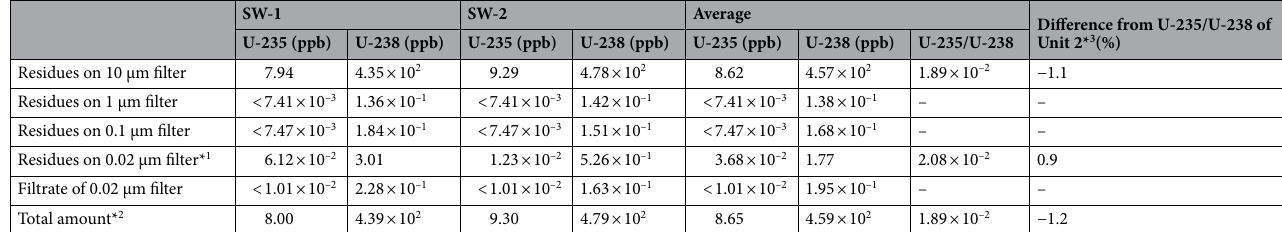
Table 1. U concentrations in the fractions of the stagnant water (SW) sample. *1 Difference in U concentration between a 0.1 and 0.02-µm filter filtrate.*2 Sum of the U concentrations of the 10-, 1-, and 0.1-µm filter residues and the 0.1-µm filter filtrate.*3 Isotope ratio of U-235/U-238 in Unit 2 was 1.93 × 10 –2 according to the JAEA Data/Code 2012–018